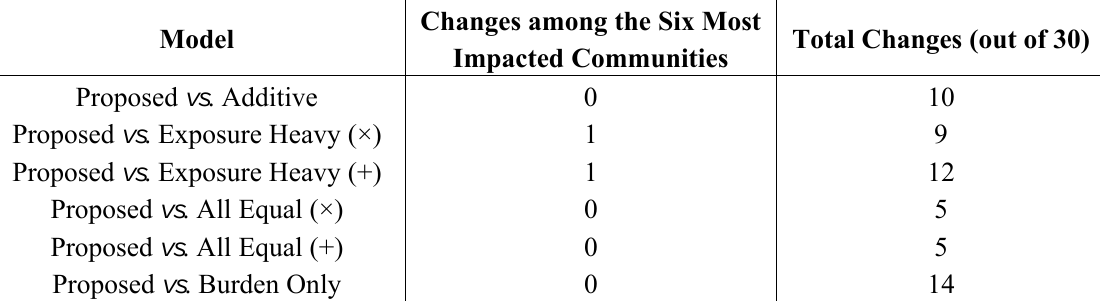
Table 4. Changes in rank associated with varying the model. Changes among the Six Most Model Impacted Communities Proposed vs .